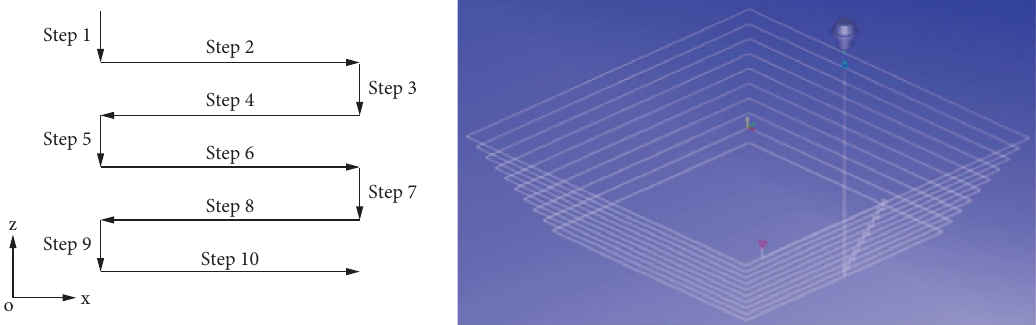
Figure 4: Tool path used in the straight groove and truncated pyramid